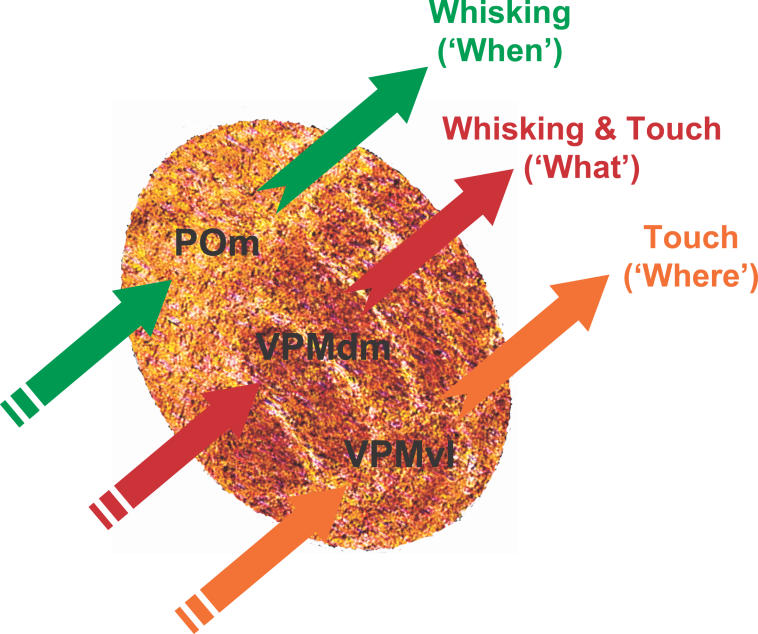
Three parallel trigeminal pathways through the thalamus convey whisking, contact, and whisking-touch signals, enabling parallel processing of sensor motion (“when”), object location (“where”), and object identity (“what”) in the whisking rat.